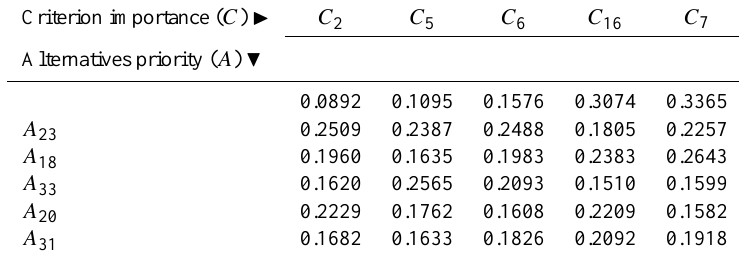
5 Table12. Decision matrix of optimal combating desertification alternatives according to group